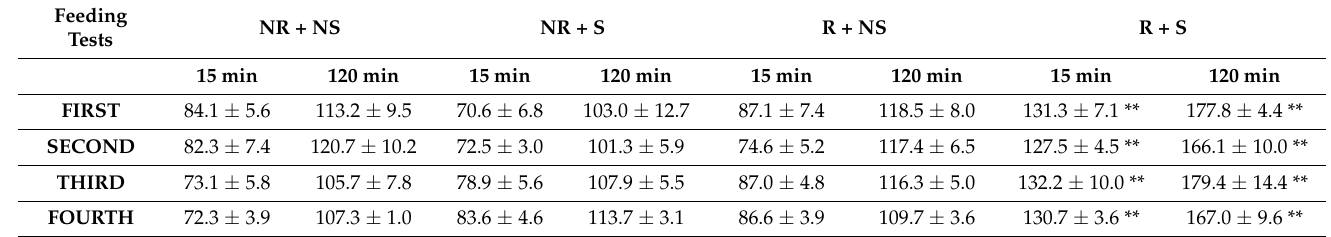
Table 1. Mean ± SEM of palatable food intake (kcal/kg) at 15- and 120-min time points during the four feeding tests in each experimental group: NR + NS: Non-restricted and Non-stressed rats; NR + S: Non-restricted and Stressed rats; R + NS: Restricted and Non-stressed rats; R + S: Restricted and Stressed rats. ** p < 0.01, different from the other three groups in each feeding test; n = 5–6 per group. Data were analyzed by two-way ANOVA in a 2 (food restriction: no, yes) × 2 (frustration stress during testing: no, yes) factorial design. Bonferroni’s post hoc tests were used to follow up on significant interaction or main effects ( p < 0.05) from the factorial ANOVAs for each feeding